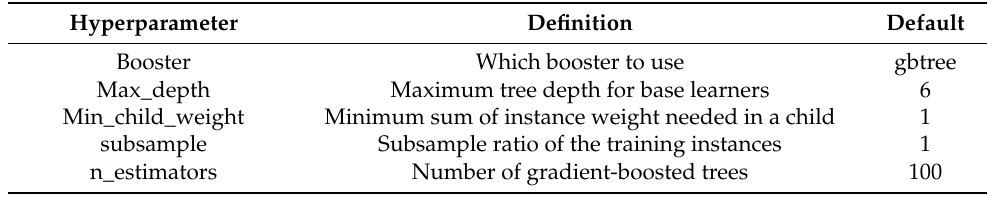
Table 2. The main parameters of the XGBoost algorithm.